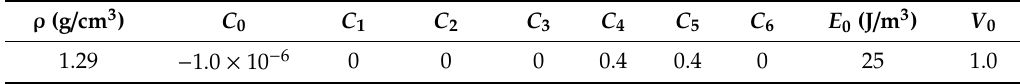
Table 7. Parameters of air.